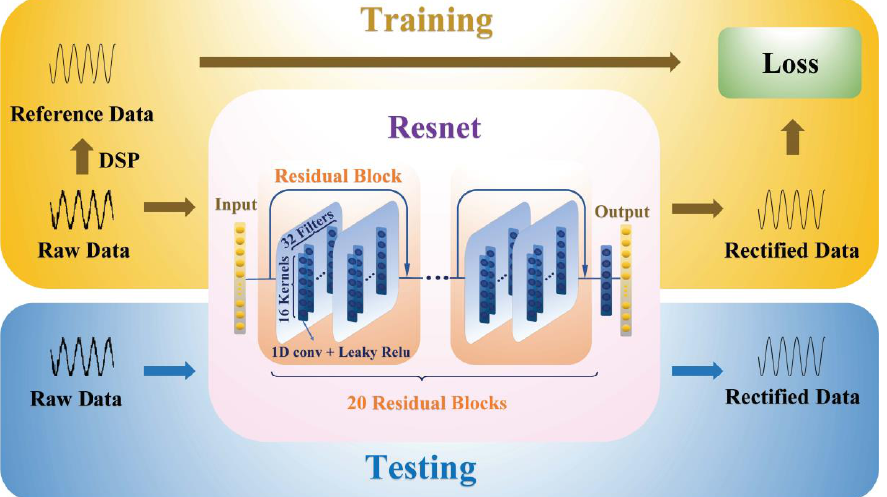
Figure 2. The schematic diagrams of the training (yellow block) and testing (blue) process and the architecture of the deep Resnet